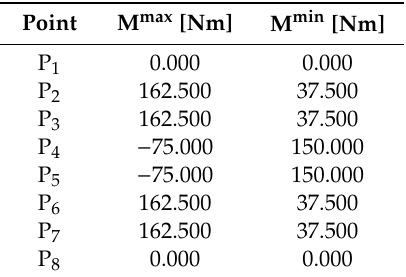
Table 3. Elastic bending moment bounds.